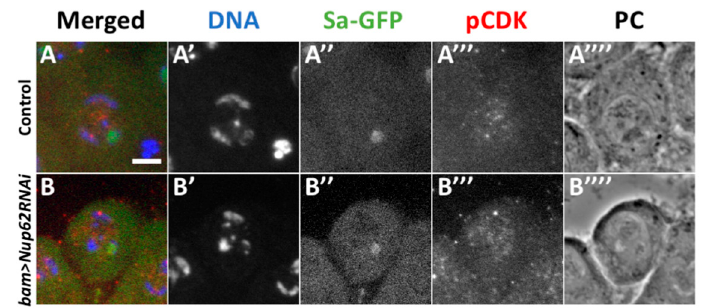
Figure 3. Normal phosphorylation of CDK1 at Thr 161 was observed in premeiotic spermatocytes depleted of Nup62 . ( A , B ) Immunostaining of premeiotic spermatocytes in S5 to S6 stages with an antibody recognizing a phosphorylated form of CDK1 at Thr 161 . ( A ) A control spermatocyte ( bam > dcr2 ), ( B ) premeiotic spermatocytes at the same stage with spermatocyte-specific depletion of Nup62 ( bam > dcr2 Nup62RNAi KK 106754 ). ( A’ , B’ ) DAPI staining. ( A” , B” ) Fluorescence of Sa-GFP for staging of spermatocytes (green in ( A ) and ( B ), white in ( A” ) and ( B” )). Immunostaining to detect phosphorylation of CDK1 at Thr 161 (pCDK) (red in ( A and ( B ), white in ( A”’ ) and ( B”’ )). Phase contrast micrograph (PC) to observe cell margin and nucleolus. Bar; 10 μ m.